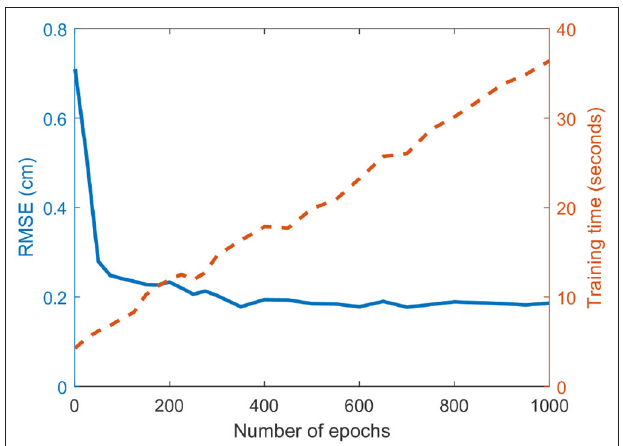
FIGURE 6 | Effect of the number of epochs on the prediction error. The RMSE and the fine-tuning training time are plotted in solid blue and dashed red lines, respectively. The training time increases linearly with the number of epochs, while the RMSE rapidly decreases at the beginning but converges at around 400 epochs.